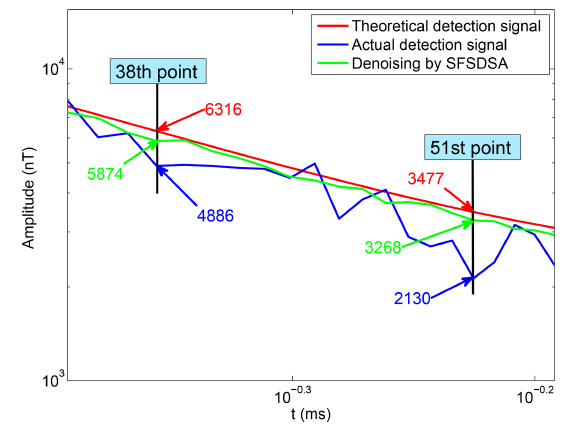
Figure 9. Specific points